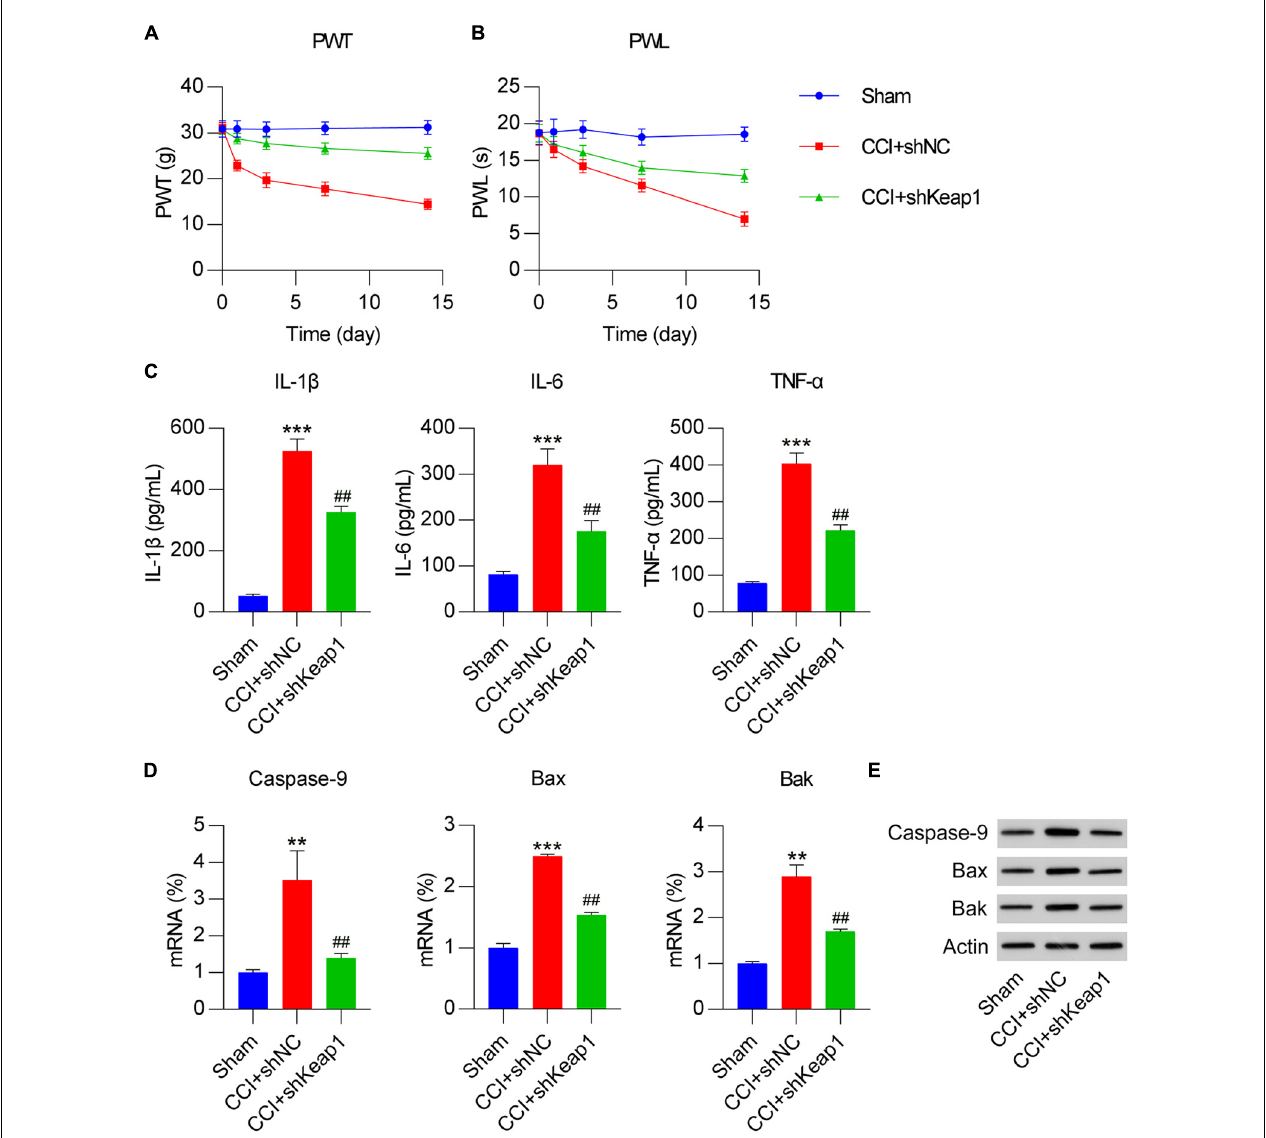
FIGURE 8 | Effect of Keap1 overexpression on Dex-alleviated neuropathic pain in CCI-induced rats intrathecally injected with lentiviral-shNC/lentiviral-shKeap1 for 1 week. Rats were then subjected to CCI surgery. (A) Paw withdrawal threshold (g) at 0, 1, 3, 7, and 14 days after operation. (B) Paw withdrawal latency (s) at 0, 1, 3, 7, and 14 days after operation. (C) Expression levels of IL-1 β , IL-6, and TNF- α was identified in the spinal cord using enzyme-linked immunosorbent assay. (D) mRNA expression levels of apoptotic factors caspase-9, Bax, and Bak in spinal cord tissues were determined using quantitative polymerase chain reaction. (E) Protein expression levels of caspase-9, Bax, and Bak in spinal cord tissues were determined using western blotting. ** P < 0.01, *** P < 0.001 vs. Sham group; ## P < 0.01 vs. CCI + shNC group.